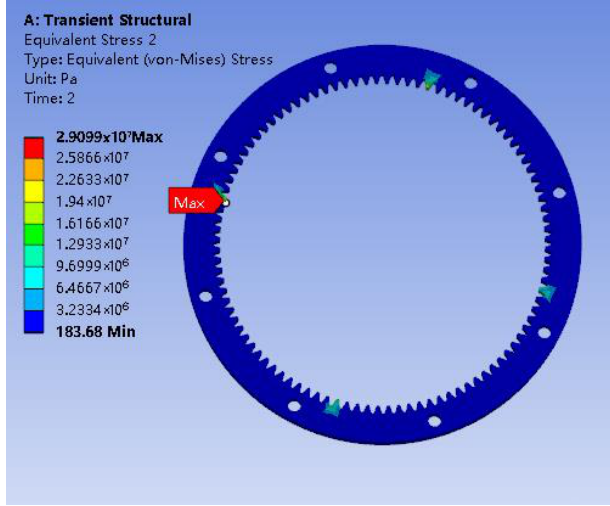
Figure 12. Equivalent stress nephogram.